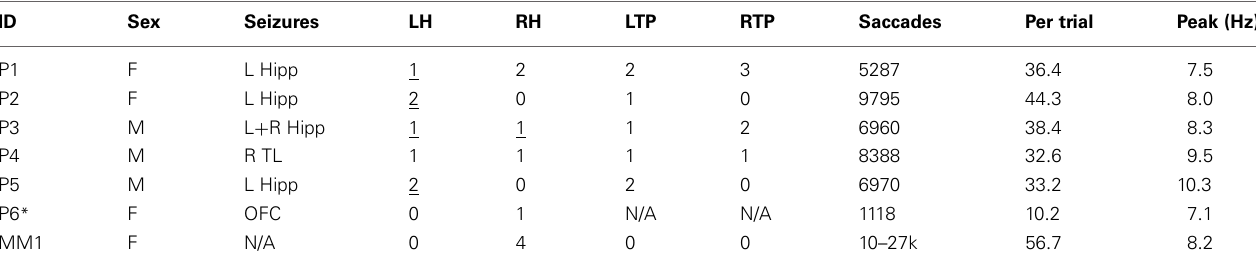
Table 1 | Subject and electrode recording